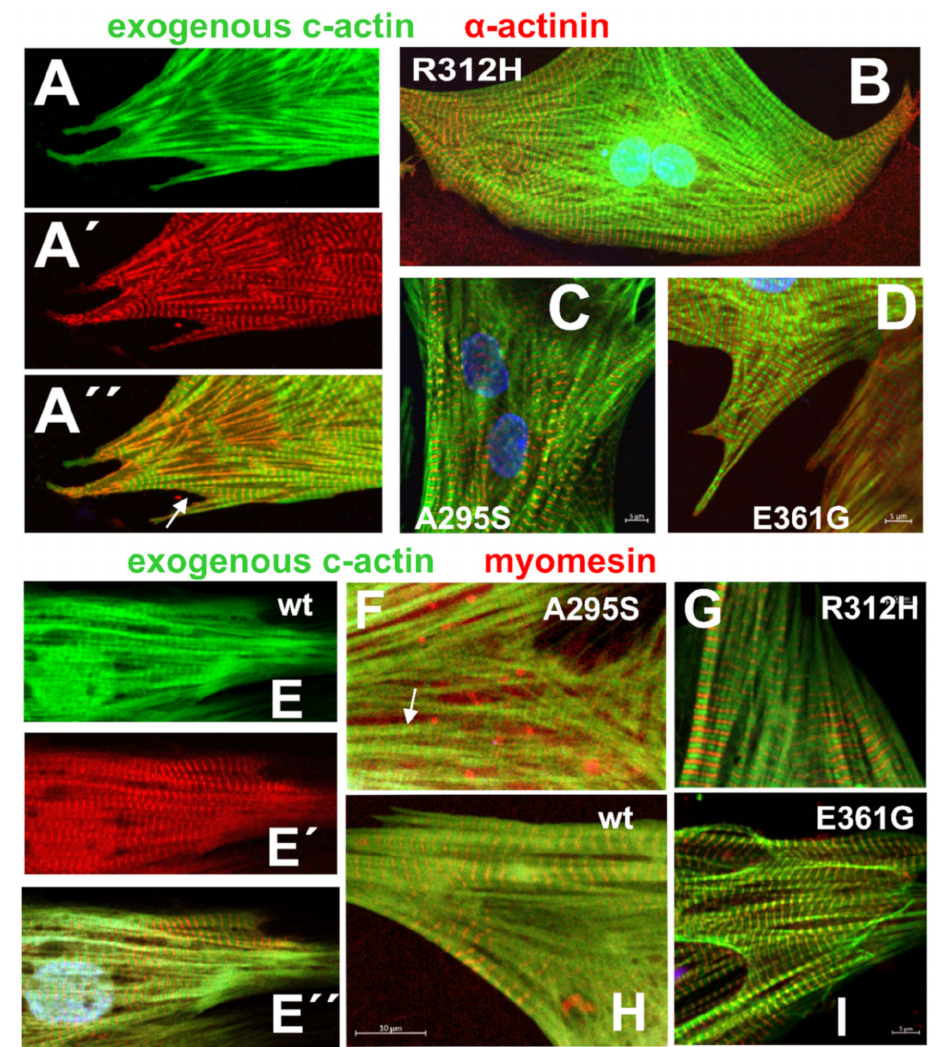
Figure 8. NRCs expressing HA-tagged c-actin variants counterstained with anti- α -actinin or anti- myomesin. ( A ) NRC transduced with vectors coding wt HA-tagged c-actin stained with anti- HA (green) were counterstained with ( A’ ) anti- α -actinin (red) showing cross-striations (arrows). ( A’’ ) gives the merged image. Note that cross-striation appears in many cases yellowish stained indicating co-localization (arrows). ( B – D ) gives merged images of identical staining protocol for p.R312H ( B ), p.A295S ( C ), and p.E361G ( D ). Note that in ( B , C ), the cross-striations are yellowish stained indicating also for HA-p.R312H and HA-p.A295S co-localization with α -actinin suggesting preferred incorporation in the region of the Z-line, i.e., at the plus-ends. In contrast, HA-p.E361G ( D ) transduced NRCs show a clear separation of the anti-HA (green) and anti- α -actinin immunostaining (red), indicating its incorporation at the minus ends in the region of the M-line. ( E – E” ) Similiar immunostaining of wt HA-tagged c-actin (green) and anti-myomesin (red). Note the separation of anti-HA and -myomesin in ( E” , H ). ( F ) Merged image for HA-p.A295S and ( G ) for HA-p.R312H c-actins. Note the separation of anti-HA and -myomesin in ( F , G ), indicating incorporation of the minus ends in the region of the M-line. In contrast, ( I ) NRCs transduced with HA-p.E361G indicate co-localization of this c-actin mutant with myomesin supporting the notion that its incorporation into sarcomeric structures occurs at the minus ends of existing actin filaments in the region of the M-line. Bars give 20 µ